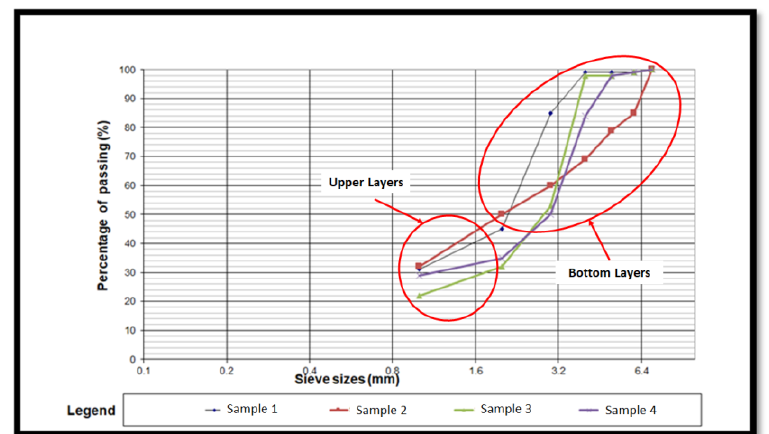
Figure 6. Gradation curve of the collected soil sample. The focus of this paper is on the upper layers. It is crucial to indicate that the gradation curves represent the mixture of upper/top layer to the bottom layer of the soil mass.